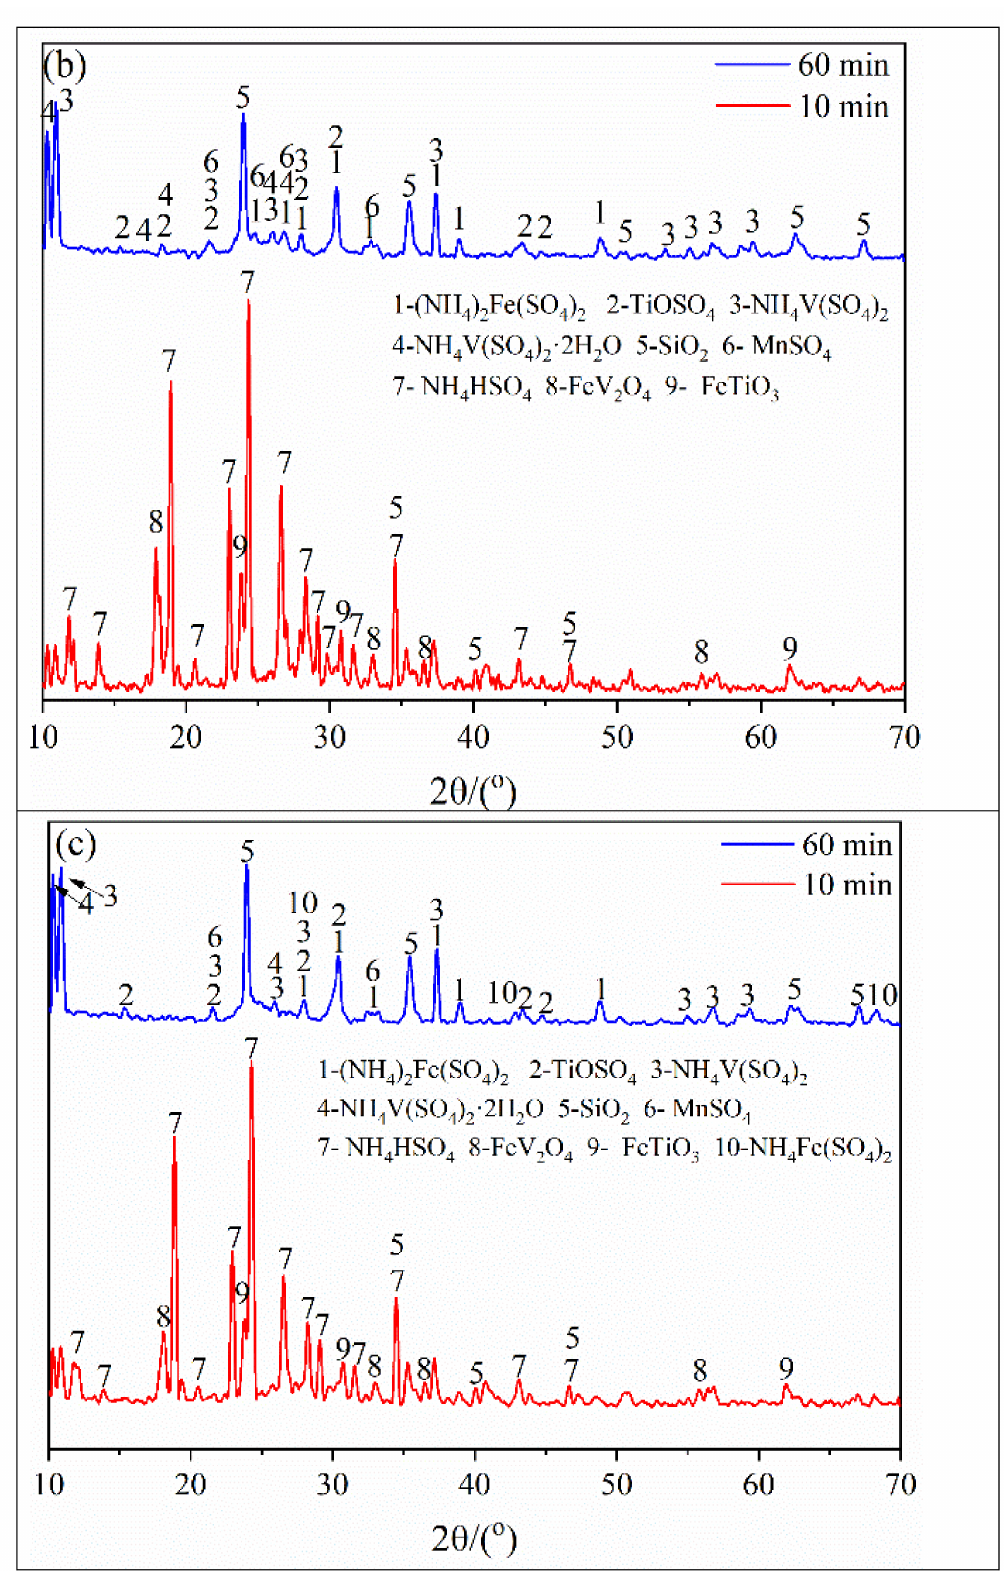
Figure 4. XRD analysis of ( a ) raw slag and roasted slag in the air ( b ) roasted slag with ABS addition in N 2 gas ( c ) roasted slag with ABS addition in the